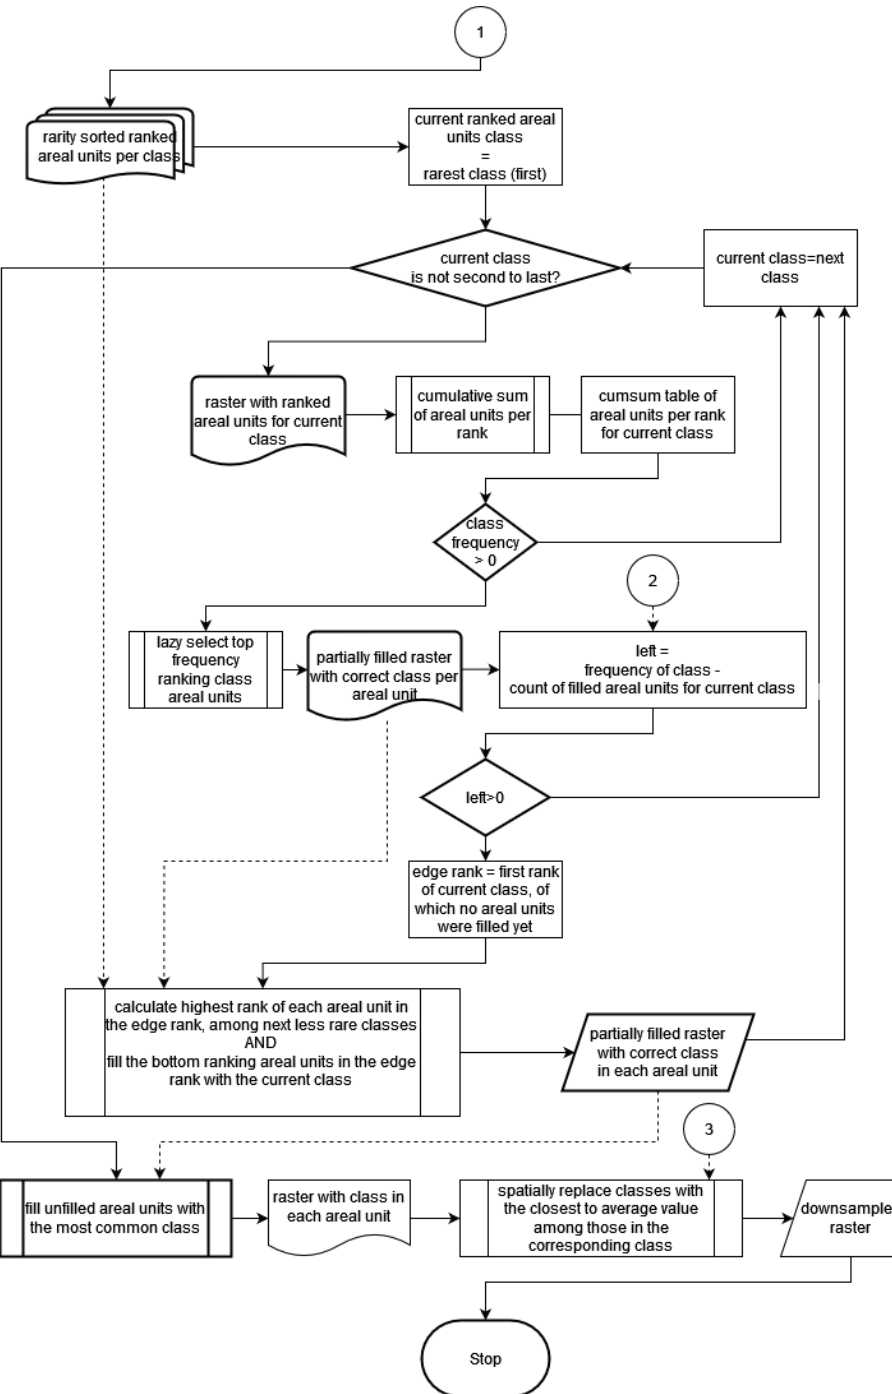
Figure A2. Flowchart of the novel downsampling method part